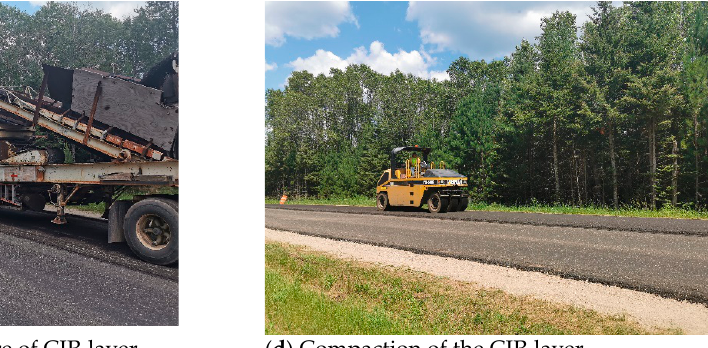
Figure 17. Original roadway condition and construction procedure: ( a ) Original road condition at northbound lane station 20+00; ( b ) View of the original existing roadway condition; ( c ) Construction procedure of CIR layer; ( d ) Compaction of the CIR layer.